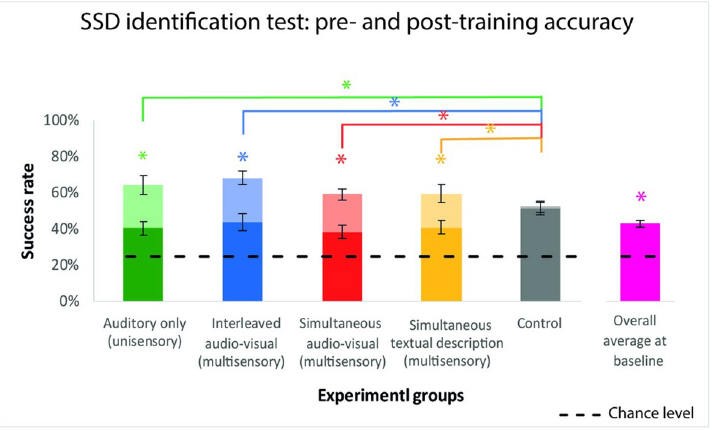
Fig 3. Pre- and post-training accuracy in the SSD identification test for all experimental groups. Baseline average accuracy level in the pre-training test is depicted in the bottom part of each stacked bar. Average accuracy in the post- training test is depicted in the top part of each stacked bar (shaded colors). First, when comparing accuracy in the pre- training test, no difference was observed between experimental groups (Kruskal-Wallis p-value = 0.2). Pooling the baseline measurement amongst all participants from all experimental conditions (43% ± 12%, pink bar) was significantly higher than a chance level of 25% (two-sample t-test, unequal variance, p < 0.00001, asterisk on top of the bar). Importantly, post-training accuracy rate in each of the four training groups was significantly higher than their accuracy in the pre-training SSD identification test (Wilcoxon sign-rank, auditory only (unisensory) p-value = 0.004; interleaved audio-visual (multisensory) p-value = 0.002; simultaneous audio-visual (multisensory) p-value = 0.002; simultaneous textual description (multisensory) p-value = 0.0098). This was not the case in the control group (Wilcoxon sign-rank, p-value = 0.9) (asterisks on top of the stacked bars). Additionally, when calculating the improvement-in-accuracy index as the difference in accuracy between pre- and post-training tests (shaded bar graphs), a significant effect emerged among experimental groups (Kruskal-Wallis p-value = 0.006). Post-hoc Wilcoxon rank- sum analysis revealed that this was driven by a significant difference between the control condition and all four training conditions (auditory only (unisensory) vs. control p-value = 0.006, interleaved audio-visual (multisensory) vs. control p-value = 0.001, simultaneous audio-visual (multisensory) vs. control p-value = 0.002, simultaneous textual description (multisensory) vs. control p-value = 0.03), while no other differences were significant (all p-values > 0.33). Note that in all the stacked bars depicted here, error bars show the standard error. the different training conditions (auditory = 40% ± 11% (average ± SD), interleaved audio-